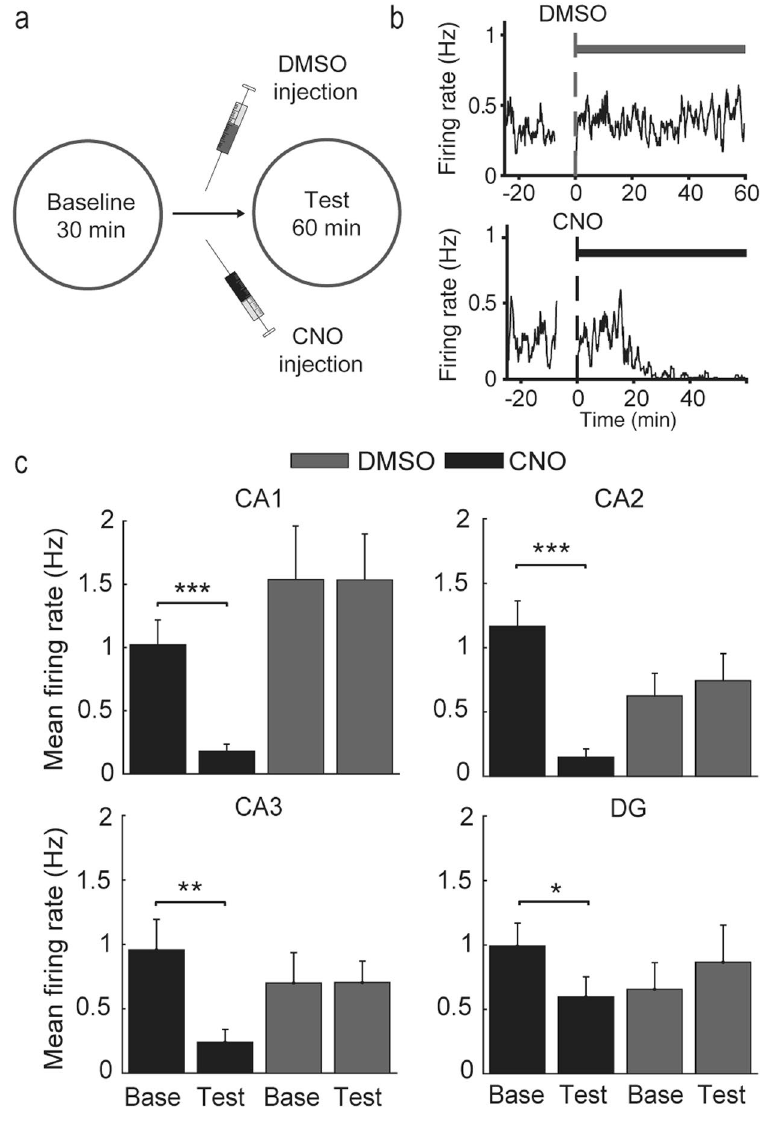
Figure 2. CNO-induced suppression of hippocampal neuronal activity. ( a ) Experimental scheme. ( b ) Examples showing effects of DMSO or CNO injection on CA1 neuronal activity. Time 0 indicates the time of resuming unit recording after DMSO/CNO injection (i.p.) at − 10 min. Neuronal activity began to be suppressed ~25 min following CNO injection. ( c ) Group data. Mean unit discharge rates 0–10 min before (Base) and 40–50 min after (Test) DMSO or CNO injection (mean ± SEM, * p < 0.05, ** p < 0.01, *** p < 0.001, paired t -test). Only putative pyramidal and granule cells were included in the